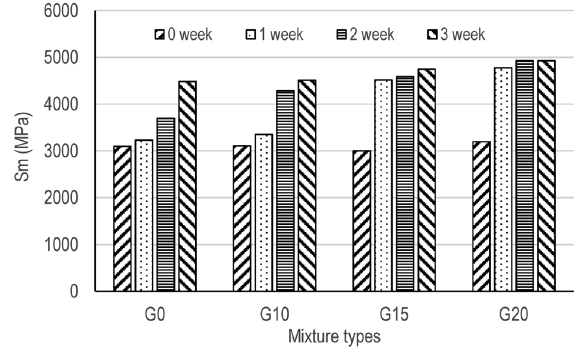
Fig. 10. The load repetition numbers of the mixtures at 4 mm